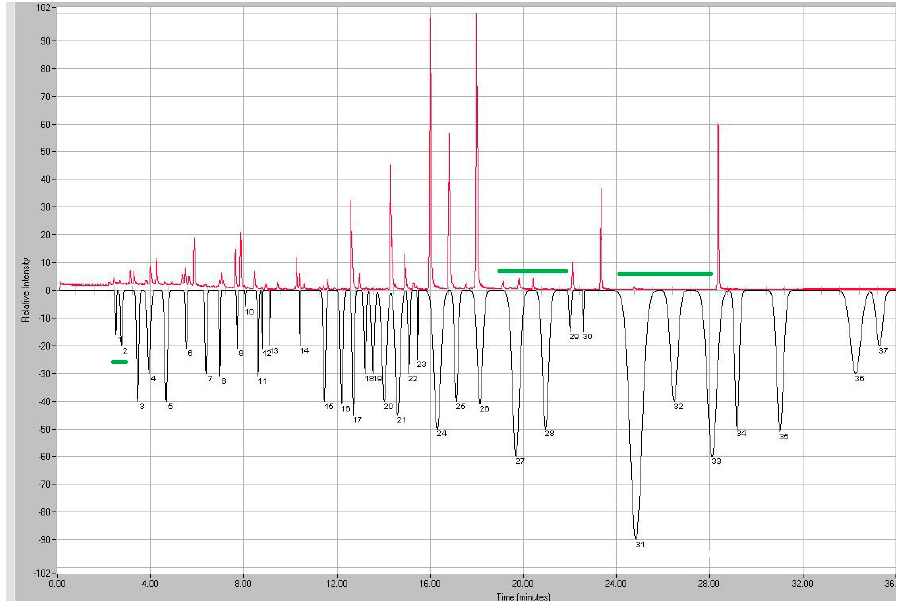
Figure 3. An overlay of the aromagram and total ion chromatogram of the fresh cat feces exposed to the SPME fiber for 50 min at 37 °C: an increase in the black signal height represents an increased intensity of odor, and the chromatogram is in red for the total ion chromatogram (TIC) signal. The green zone shows that trace levels of the concentration of malodors can produce an intense olfac- tory response detected by the panelist using GC–MS–O.